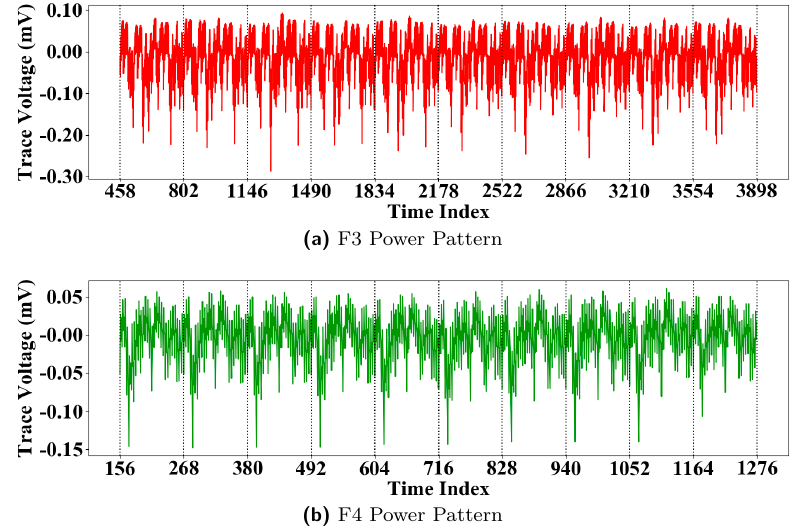
Figure 4: The Power Patterns of Both Target Devices